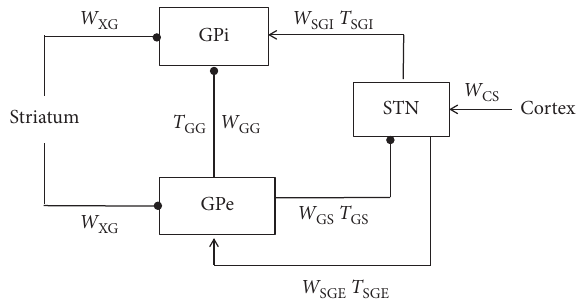
Figure 1: Schematic diagram of STN-GPe-GPi. Each rectangular represents neural population, arrows indicate excitatory inputs, lines ending with black dots mean inhibitory inputs, and the striatum and cortex represent their inputs,